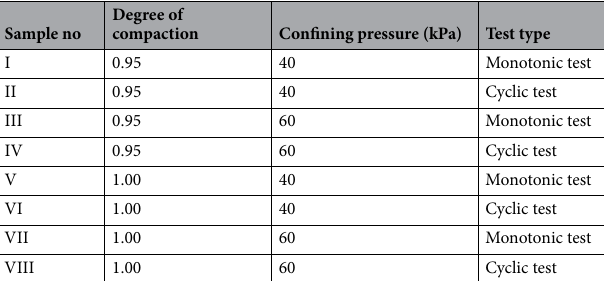
Table 2. Test scheme.